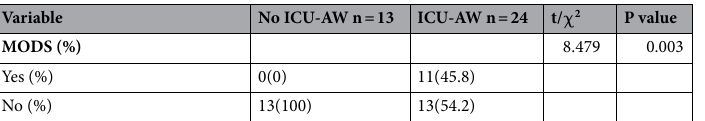
Table 1. Patient characteristics. ICU-AW, intensive care unit acquired weakness; MRC, Medical Research Council; BMI, Body Mass Index; APACHE II, acute physiology and chronic health evaluation II; SOFA, Sequential Organ Failure Assessment; M, mean; SD, standard deviation; IQR, interquartile range; MODS, multiple organ dysfunction